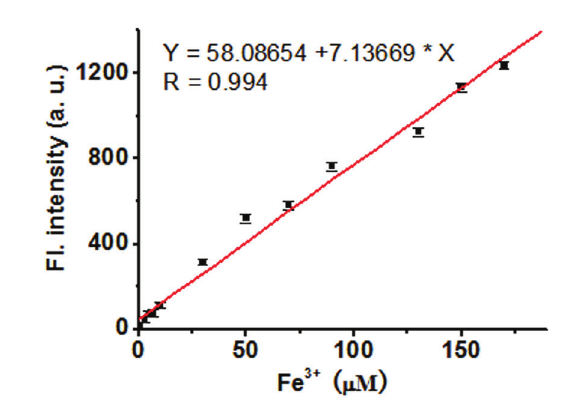
Figure 1 : Fluorescence spectra of sensor Rh6G-1 (10 μM) in the presence of increasing concentrations of Fe 3+ (0-50 equiv.) in water (containing 1% DMSO as a cosolvent) with excitation at 500 nm. Inset: Fluorescent intensity at 556 nm of sensor Rh6G-1 (10 μM) upon addition of Fe 3+ (0-50 equiv.) excited at 500 nm, and the visual fluorescence color changes of the solutions a, b: a, sensor Rh6G-1